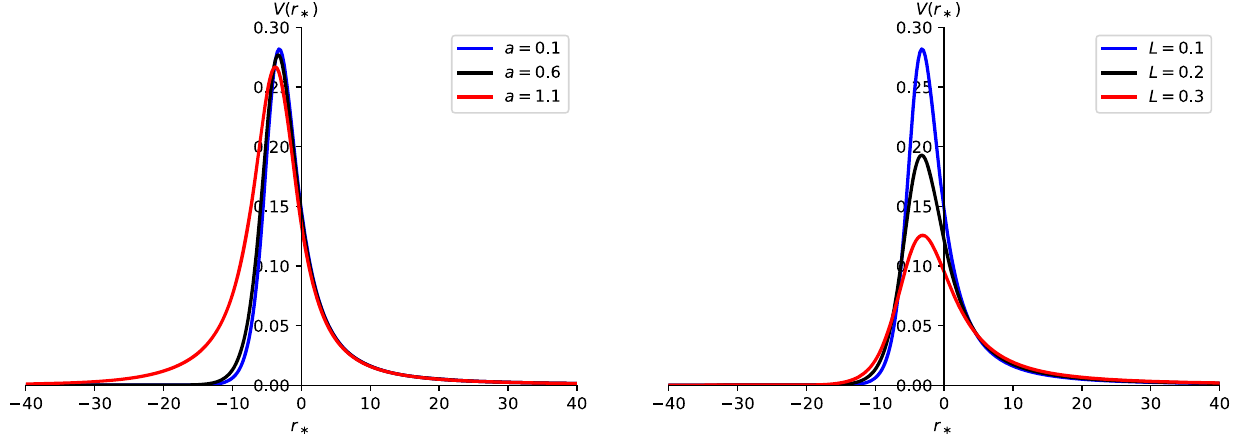
Fig. 1 The effective potential of the scalar field perturbation for different a (left panel) with M = 0 . 5 , l = 1 , L = 0 . 1 and for different L (right panel) with M = 0 . 5 , l = 1 , a = 0 . 1